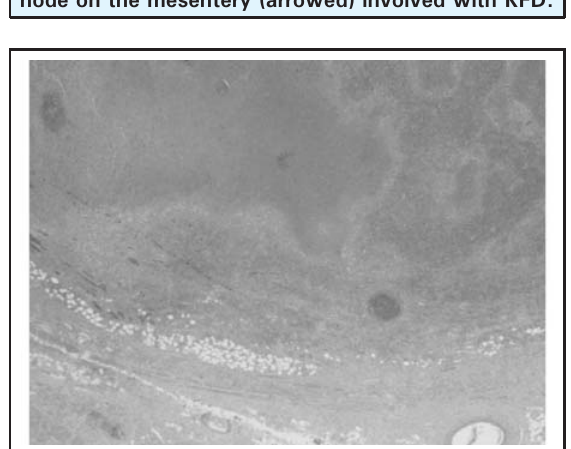
Figure 2. Section of a lymph node showing geograph- ic areas of necrosis.